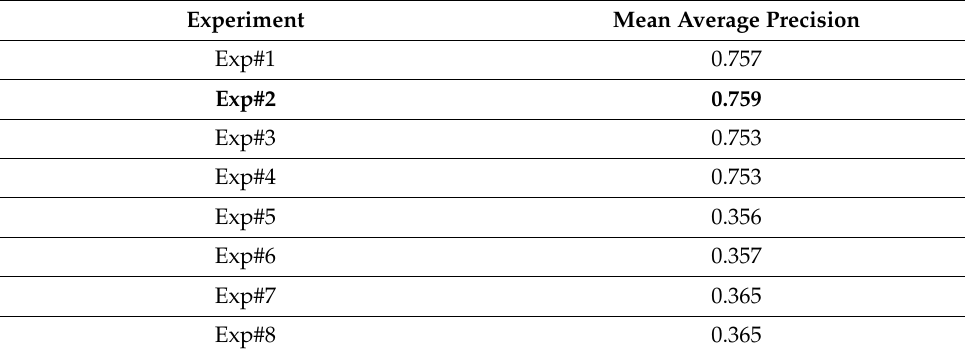
Table 2. Mean average precision results for each experiment.